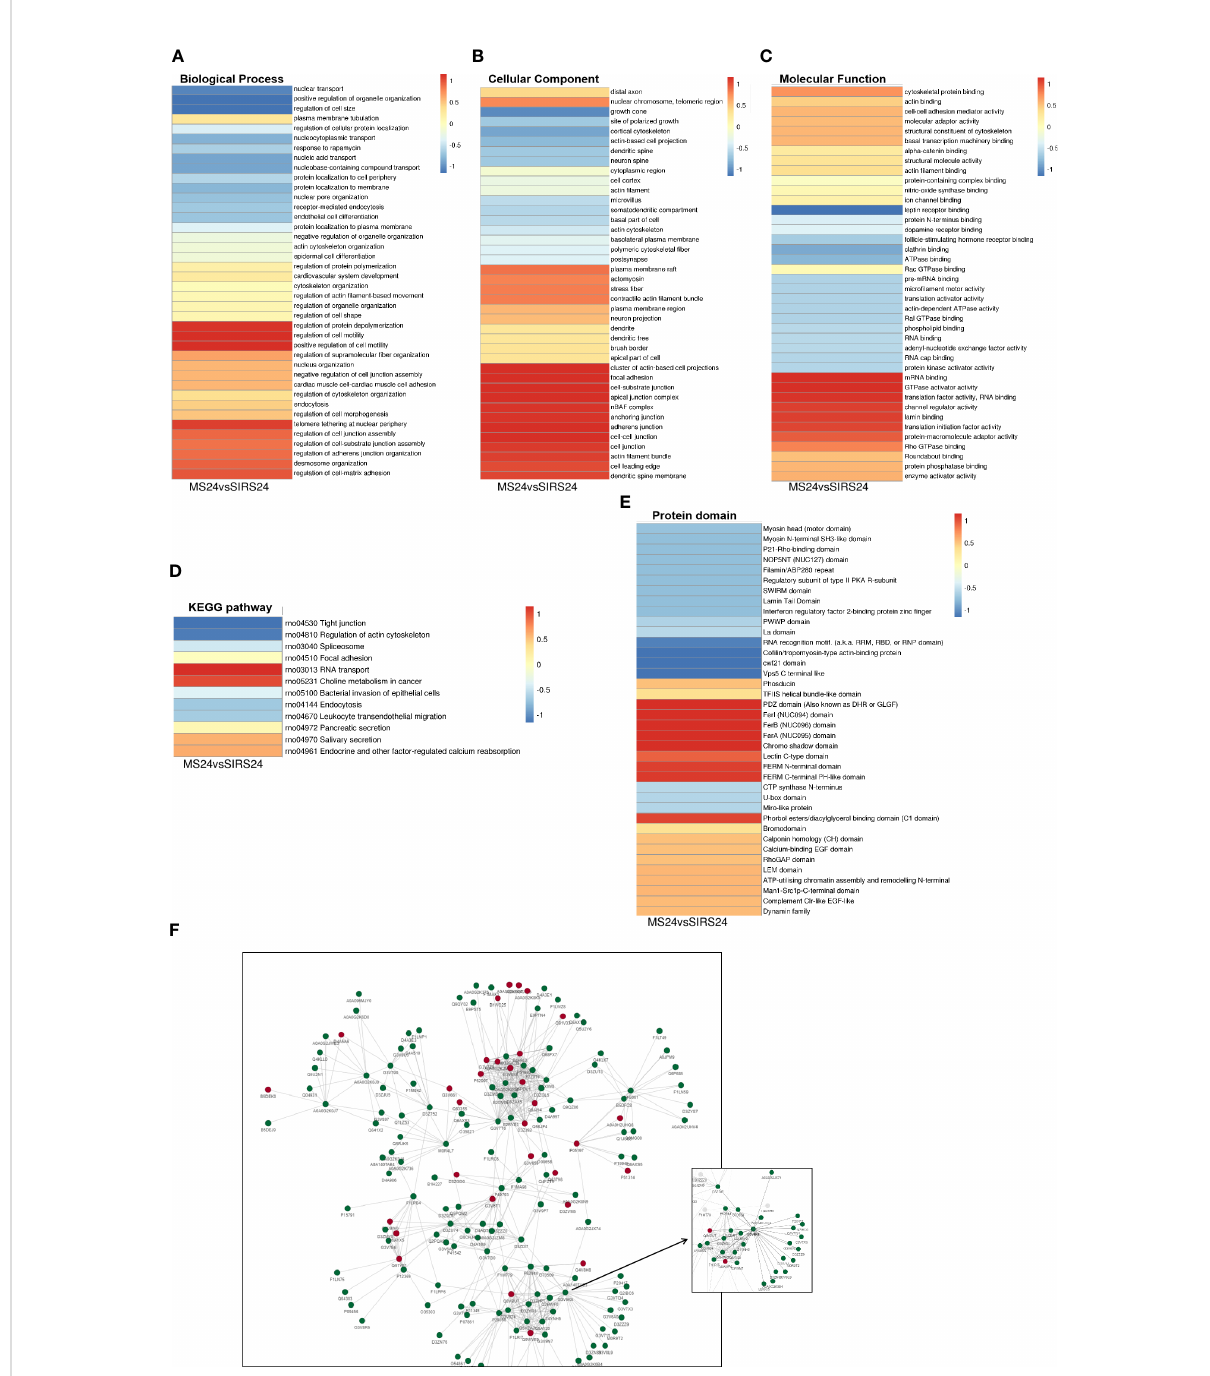
FIGURE 9 Cluster Analysis and Protein interaction network (PPI) of DDPs. Biological process cluster analysis of GO (A) . Cell component analysis of GO (B) . Molecular function analysis (C) . Cluster analysis of KEGG pathway (D) . Cluster analysis of protein domains (E) . The top 50 phosphorylated proteins with the closest interaction were selected, and a network containing a total of 173 related phosphorylated proteins was generated. G3V6K6 (EGFR) has 29 nodes (F)